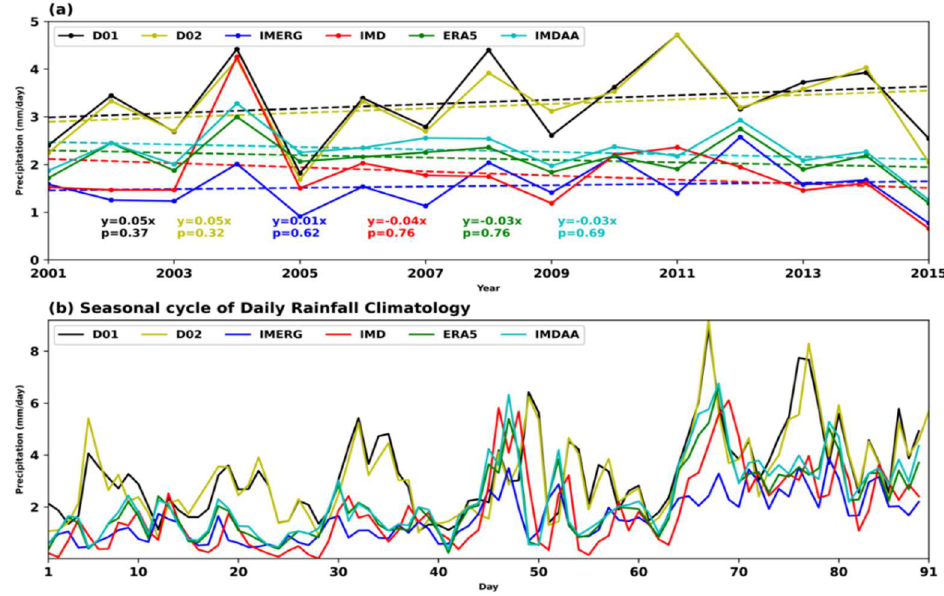
Figure 5. Temporal trends in area-averaged seasonal (DJF) precipitation ( a ) and daily climatology of area averaged precipitation ( b ).